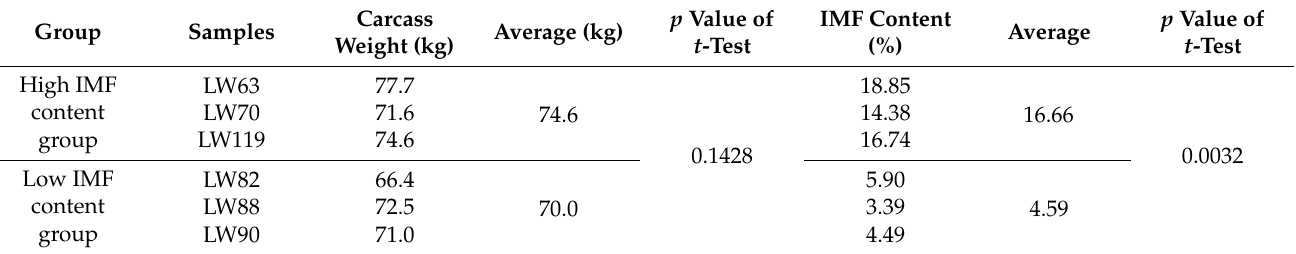
Table 1. Information of samples used in the study.